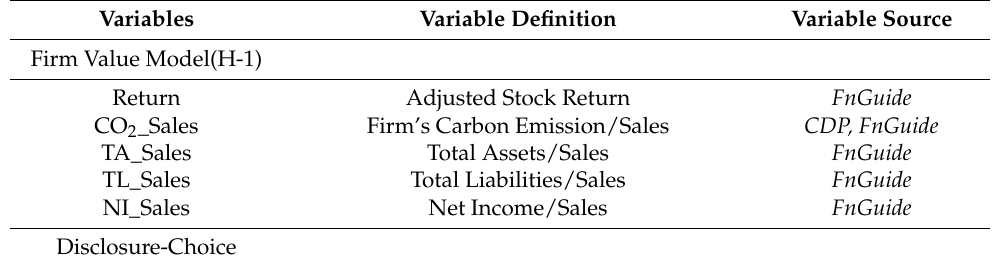
Table 3. Variable